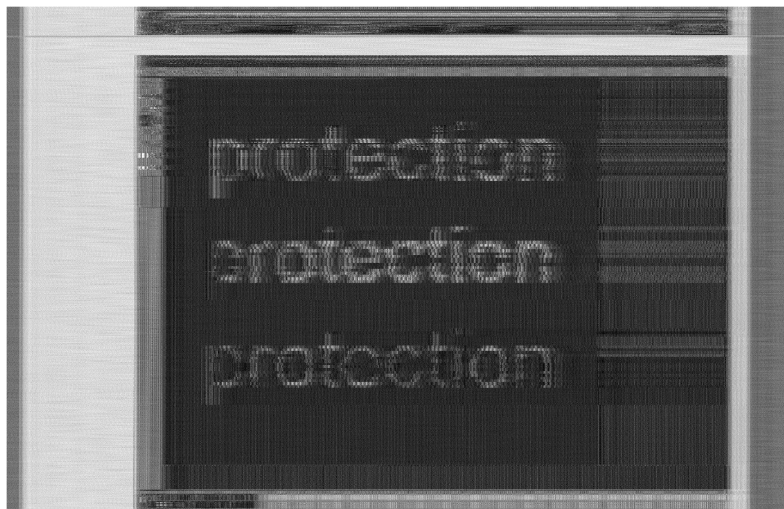
Figure 17. An example of an image obtained based on compromising emanations measured in the frequency f o = 642 MHz ( BW = 100 MHz, sampling frequency f s = 250 MHz).